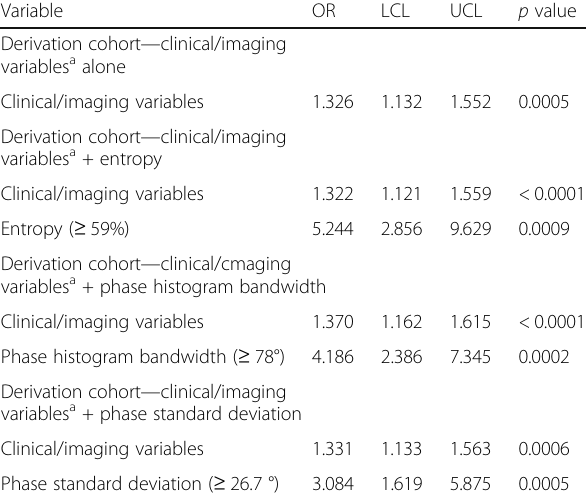
Table 5 Multivariable analysis of the phase analysis